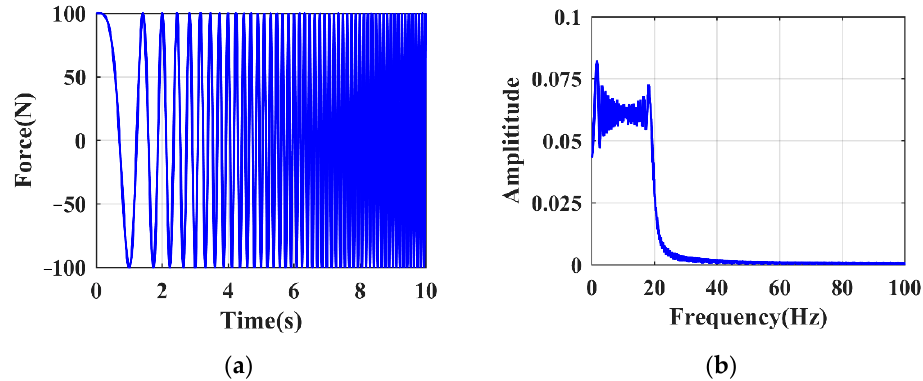
Figure 1. Typical swept frequency excitation: ( a ) time domain; ( b ) frequency domain.